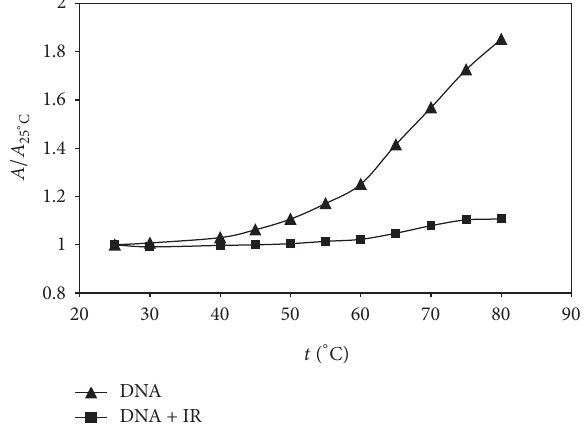
DNA DNA + IR F 7: ermal denaturation pro�le of ds-DNA in the absence and presence of CPT-11.